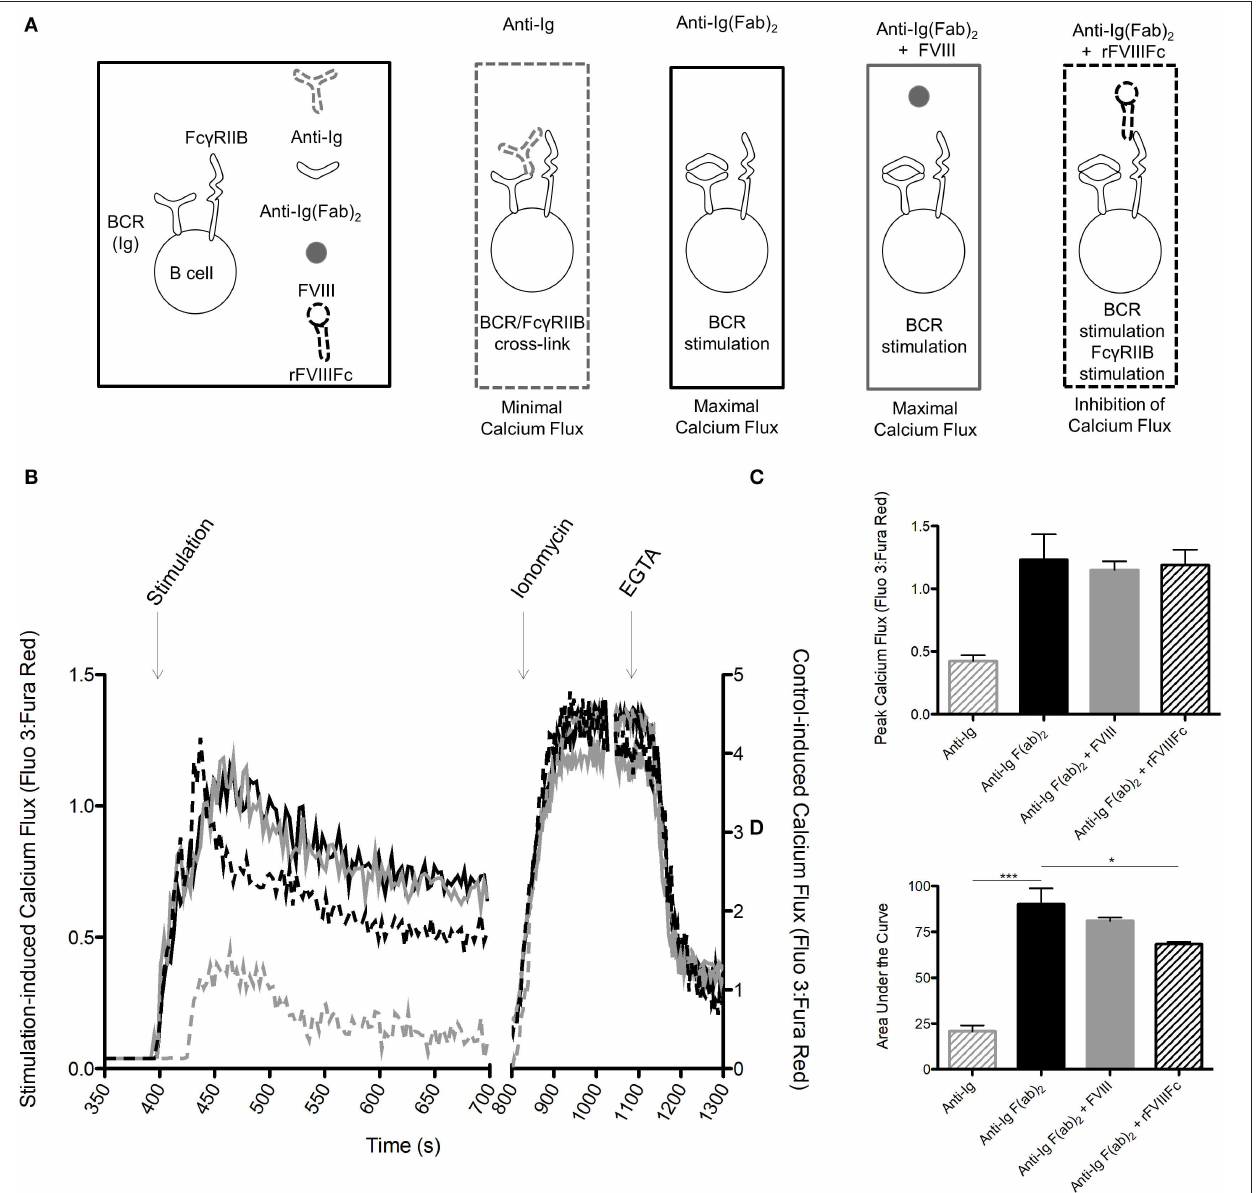
FIGURE 5 | rFVIIIFc inhibits anti-Ig F(ab) 2 induced calcium flux in B cells. (A) Calcium flux assay stimulation conditions and their hypothesized outcomes. (B) Representative graph of calcium flux assay results. (C) Peak calcium flux and (D) area under the curve for B cells stimulated with anti-Ig (10 µ g/ml), anti-Ig F(ab)